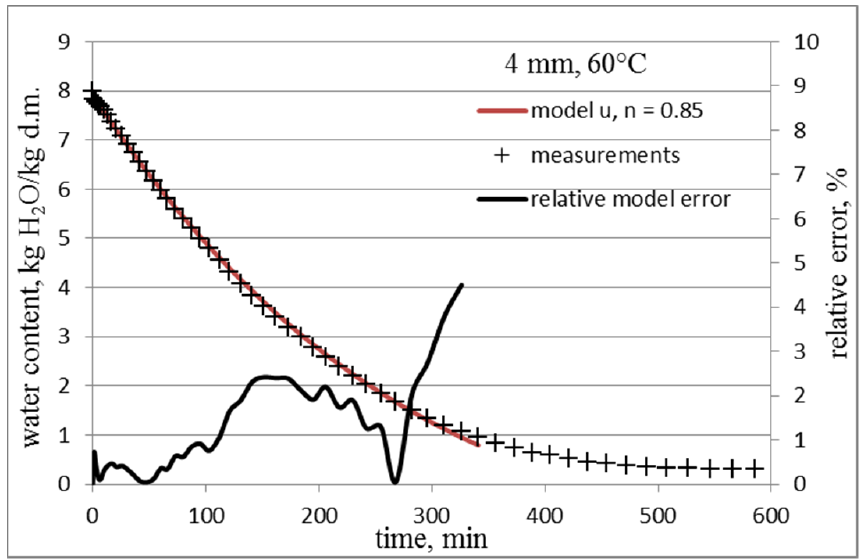
Figure 1. Model of water content changes in leek slices 4 mm thick, during drying at temperature 60 °C, when n = 0.85.